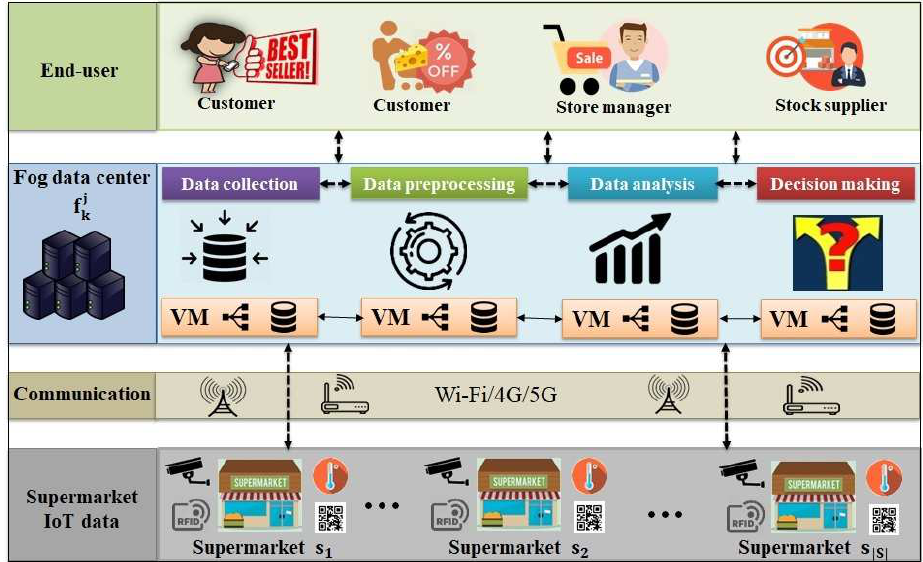
Figure 1. Proposed system